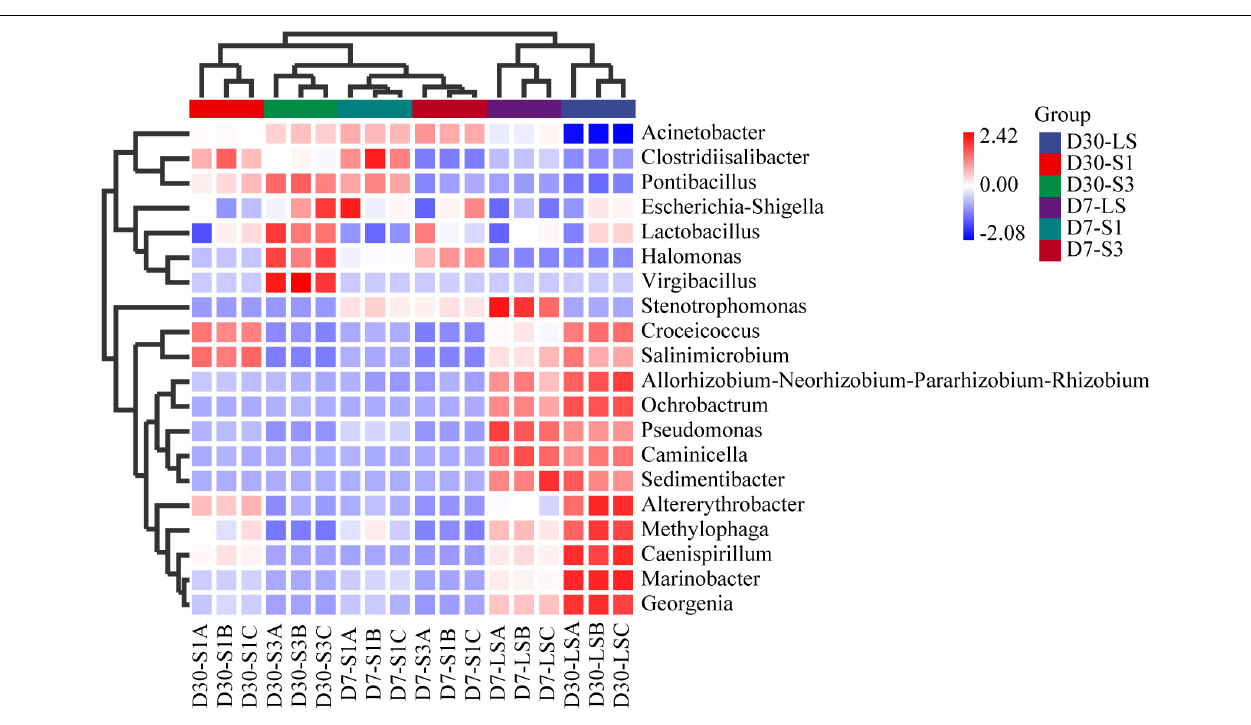
FIGURE 8 | Heatmap of the top 20 genera in soils from each